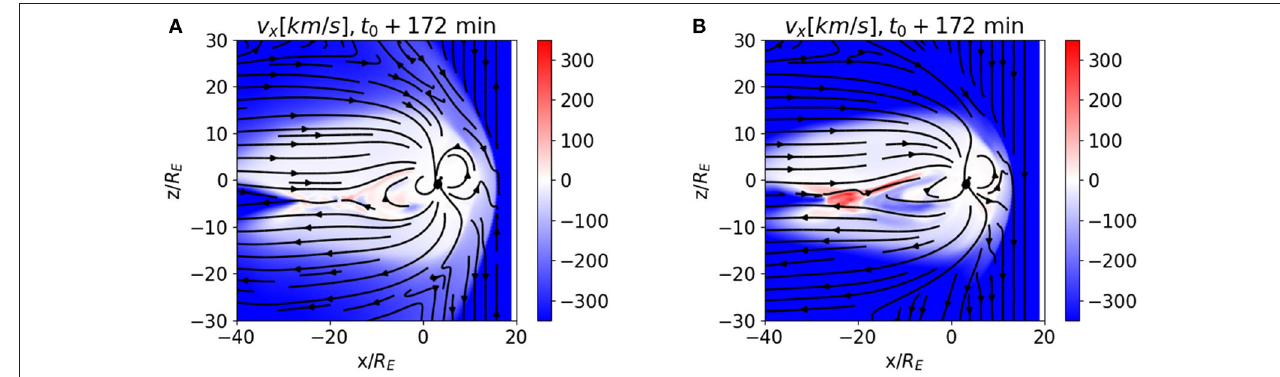
FIGURE 2 | v x field component, at the same time as Figure 1 , for the ensemble member with the lowest (A) and highest (B) absolute value of the perturbed, inflowing v x velocity component in the OpenGGCM ensemble.